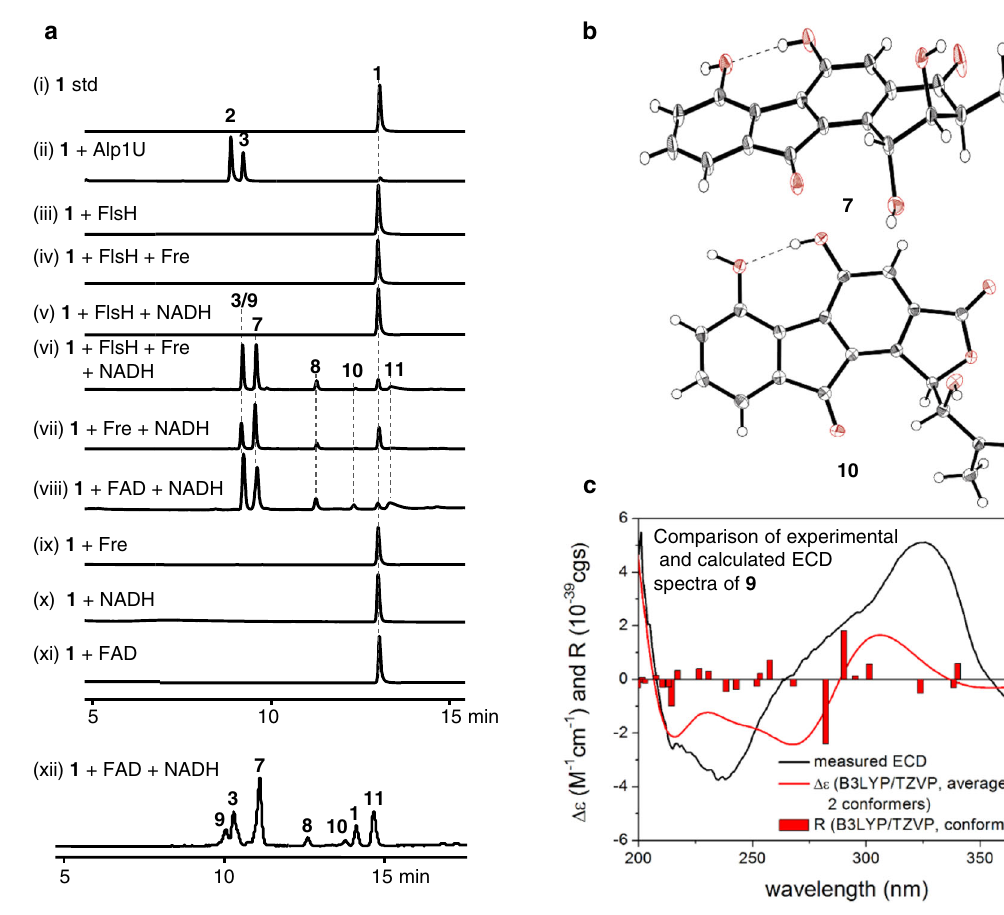
enzyme(s) (Alp1U, FlsH or Fre), 100 μ M FAD and 10mM NADH. b The X-ray crystal structures of 7 and 10 . c Experimental ECD spectrum of 9 (black line) compared with the B3LYP/TZVP PCM/MeCN // ω B97X/TZVP PCM/MeCN spectrum of (1 R ,2 S ,3 R )- 9 (red line). The bars represent rotational strength values for the lowest energy solution